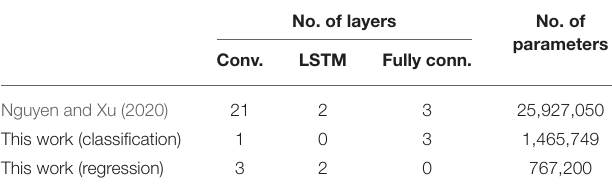
TABLE 2 | Comparison between this work and Nguyen and Xu (2020). No. of